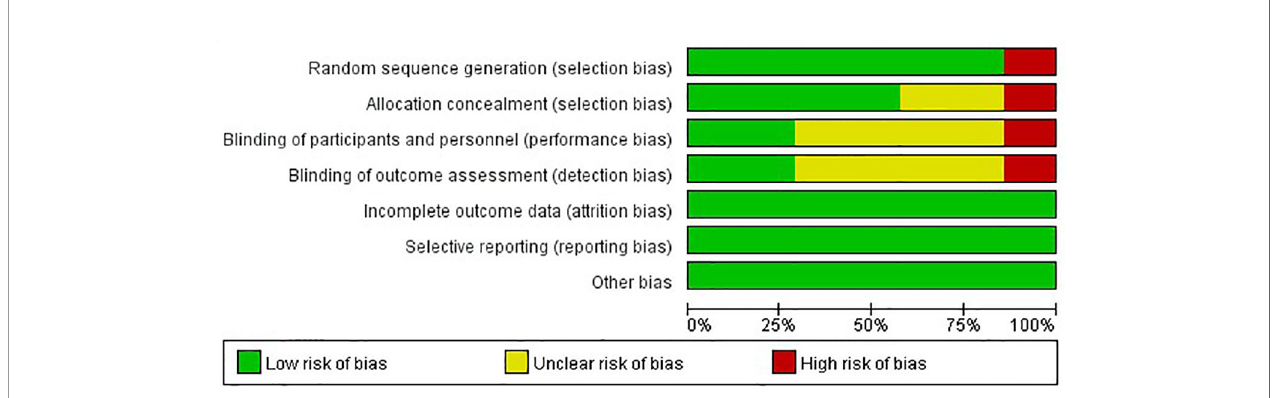
FIGURE 3 | Risk of bias for the included randomized controlled trials.